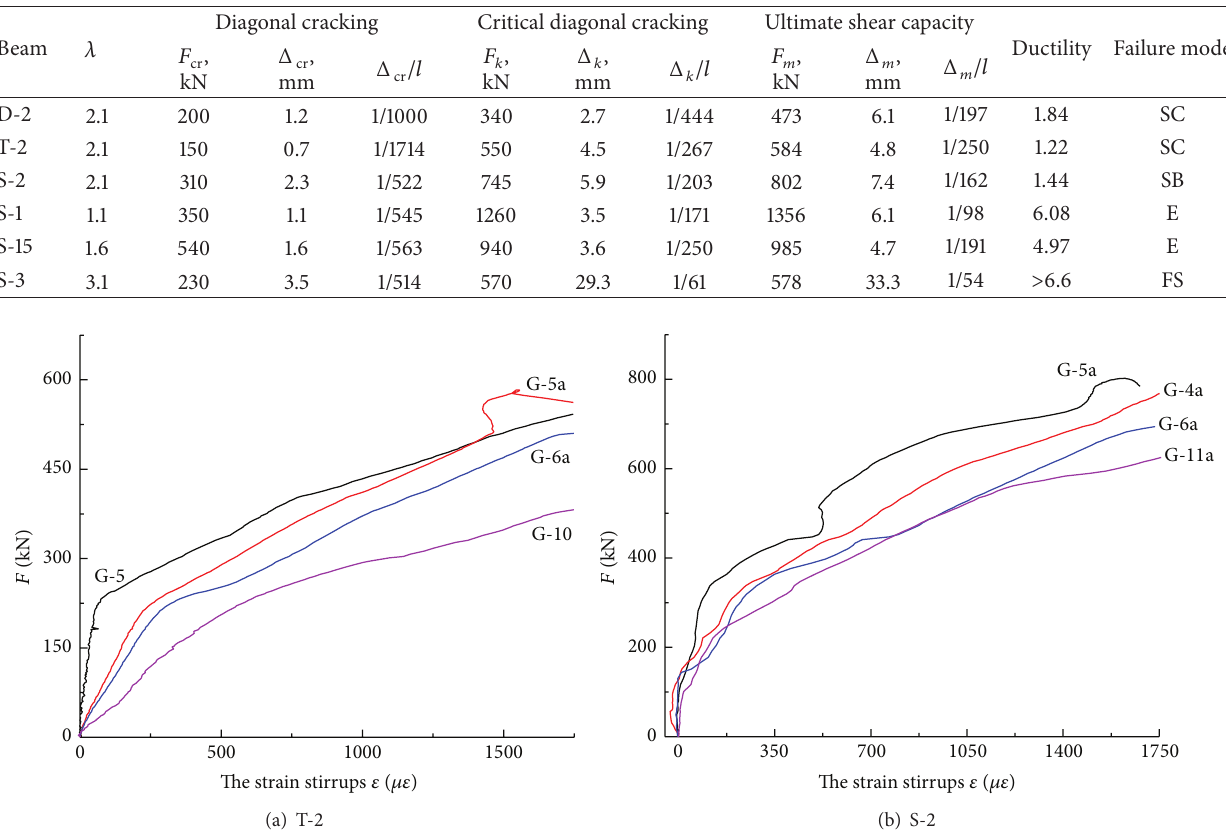
Figure 5: The strain of beam